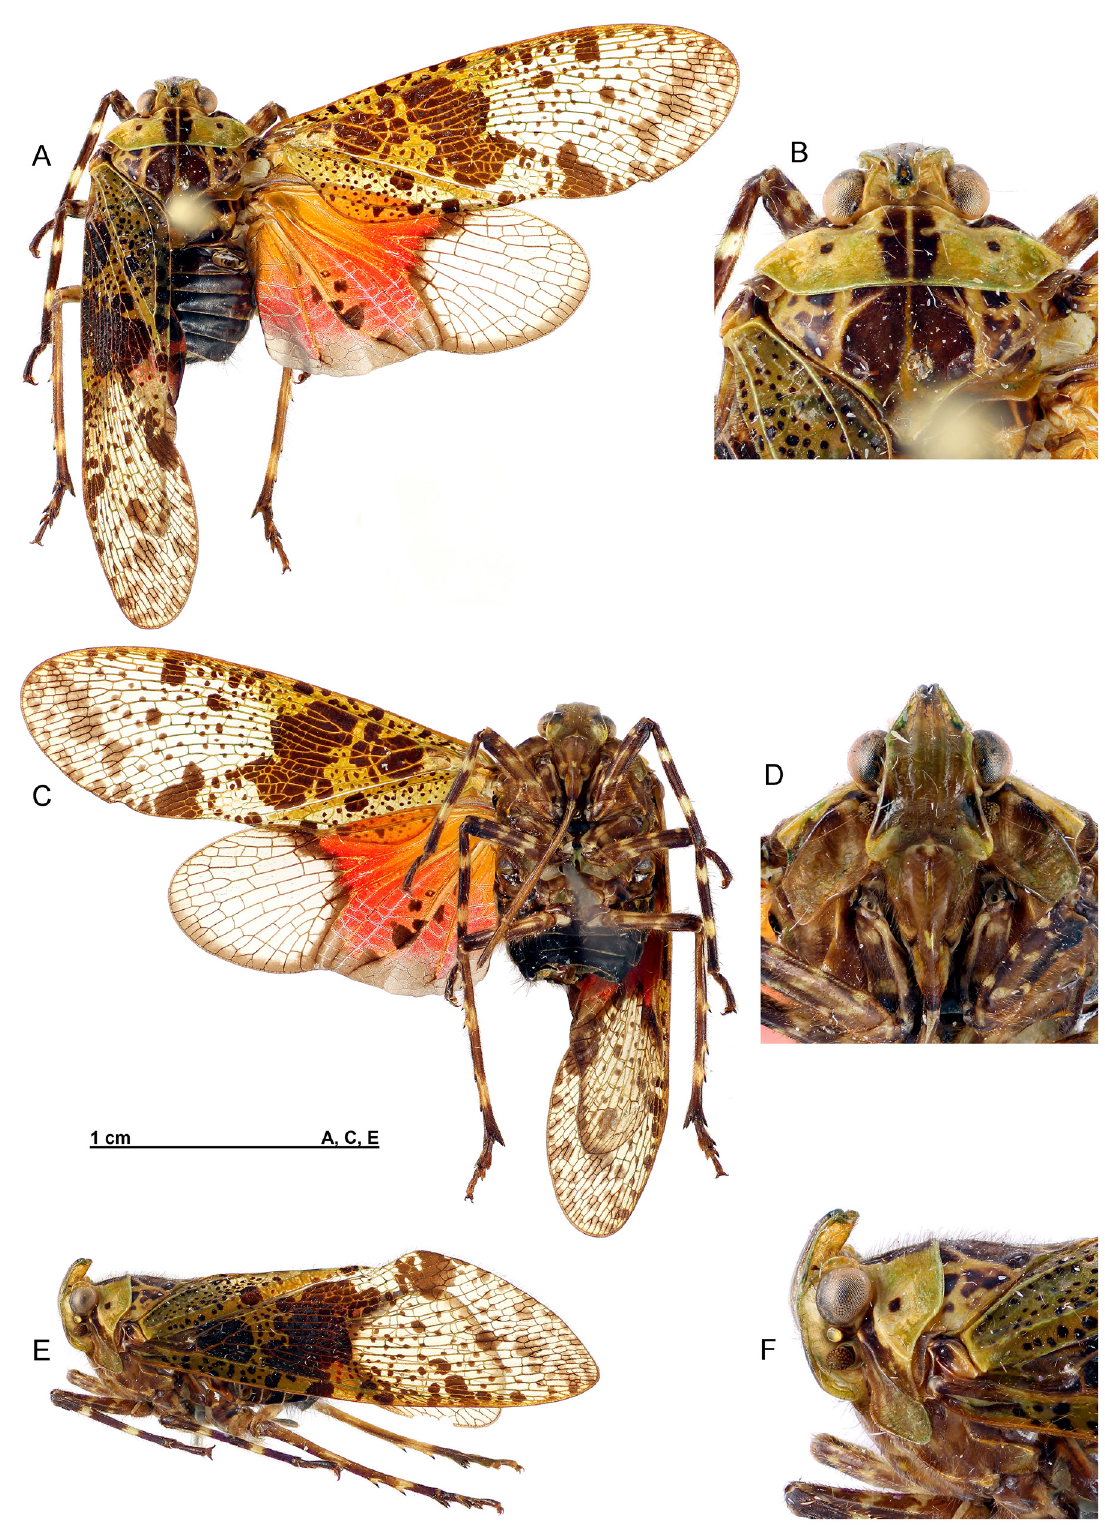
Fig. 8. Limois westwoodii (Hope, 1843), Myanmar, Nat Ma Taung, RBINS, adult male. A . Dorsal view. B . Head and thorax, dorsal view. C . Ventral view. D . Face. E . Left lateral view. F . Head and thorax, left lateral view (showing reflexed protuberance of the vertex). Photographs by J.